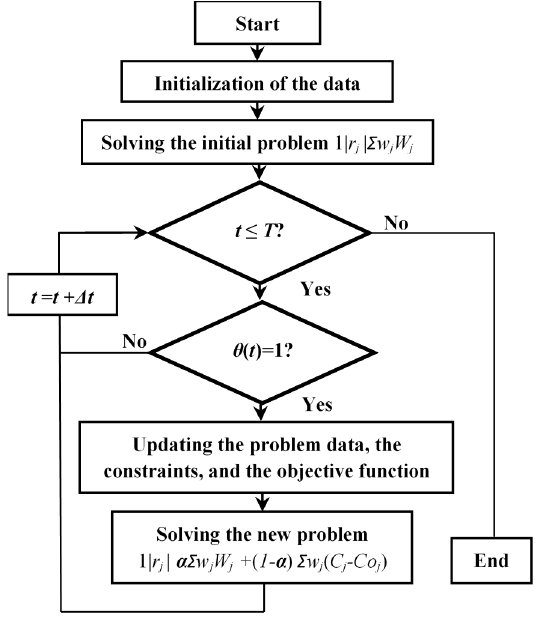
8 of 24 Algorithm 1. Rescheduling algorithm Solve the initial problem LIST = { J 1 , ..., J n } For ( t in 1 to T ) If ( θ ( t ) = 1) -